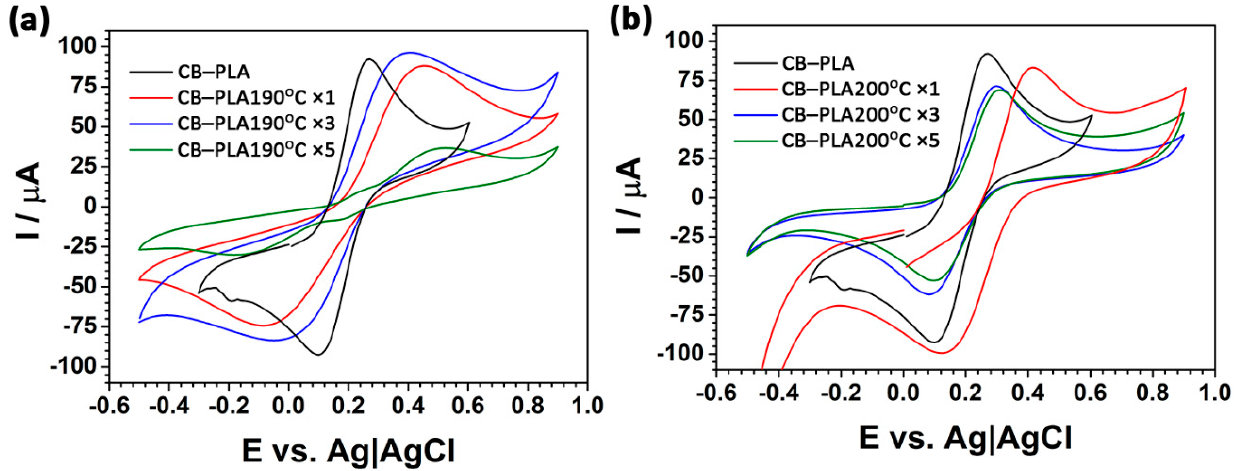
Figure 8. CV measurements of commercial filaments processed × 1, × 2, × 4 and × 6; ( a ) PP processed at 190 °C, ( b ) PP processed at 200 °C. Electrolyte: 1 mM [Fe(CN) 6 ] 3 − /4 − + 0.1 M KCl, V s = 100 mV/s .